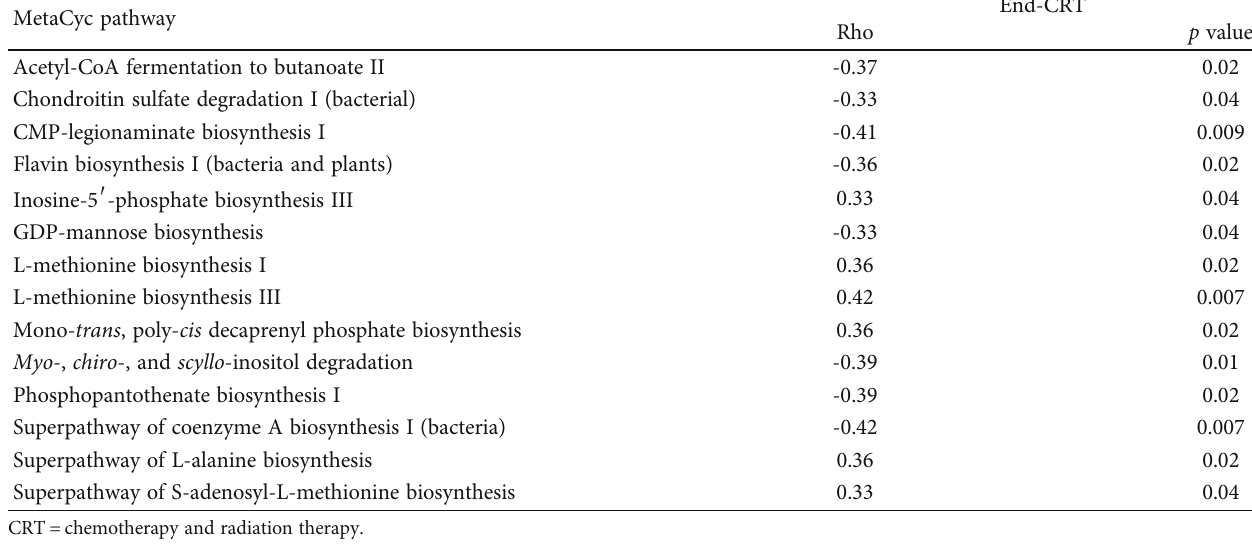
Table 4: Statistically signi fi cant correlations between MetaCyc pathway abundances and the Hamilton Depression Rating Scale scores at the end-CRT samples.